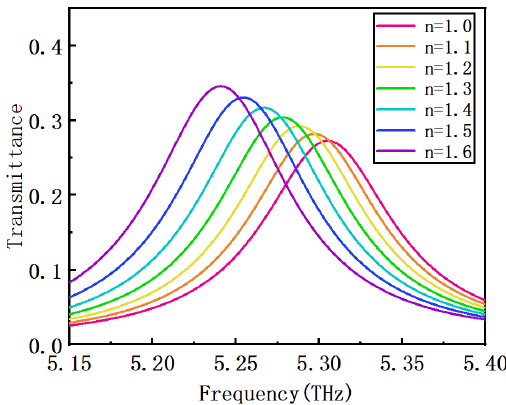
Figure 5. ( a ) Transmittance spectra for analyte height h = 4.0 µ m to h = 5.0 µ m. ( b ) Transmittance Figure 5. ( a )Transmittance spectra for analyte height h = 4.0 µm to h = 5.0 µm. ( b ) Transmittance spectra for h = 4.0 µ m to h = 9.0 µ m. spectra for h = 4.0 µm to h = 9.0 µm.